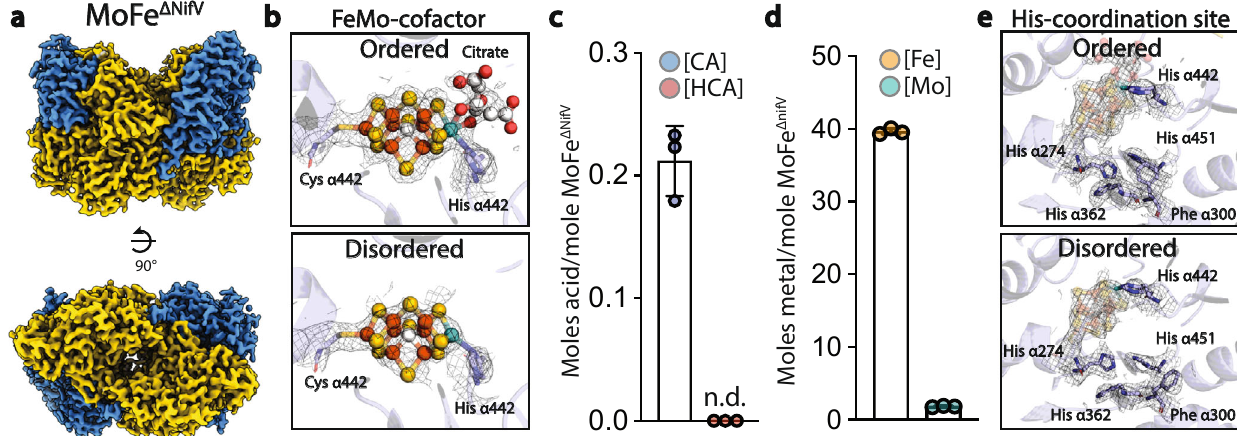
Fig. 4 | The homocitrate-de fi cient MoFe Δ NifV resembles the MoFe Alkaline-inactivated state, with partial occupancy citrate replacing homocitrate in the active site. a 2.58Å resolution cryoEM map of MoFe Δ NifV puri fi ed from A. vinelandii lacking a functional nifV gene product. b CryoEM density carved around the FeMo-cofactor at 7 σ in MoFe Δ NifV demonstrating the presence of the FeMo-cofactor coordinated by Cys α 275, His α 442,and citrate in place of the HCA site in the ordered αβ dimer (top panel). A considerableloss of recognizable density for the FeMo-cofactorand the HCA is evident in the disordered αβ dimer (bottom panel). c Quanti fi cation by anIC-MSmethoddevelopedforthisworkcon fi rmsthepresenceofcitrate(CA;blue